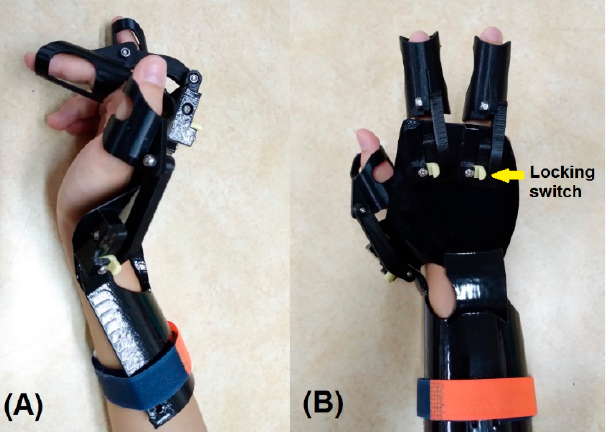
Figure 2. ( A )Lateral view and ( B ) dorsal view of a 3D-printed dynamic hand–wrist